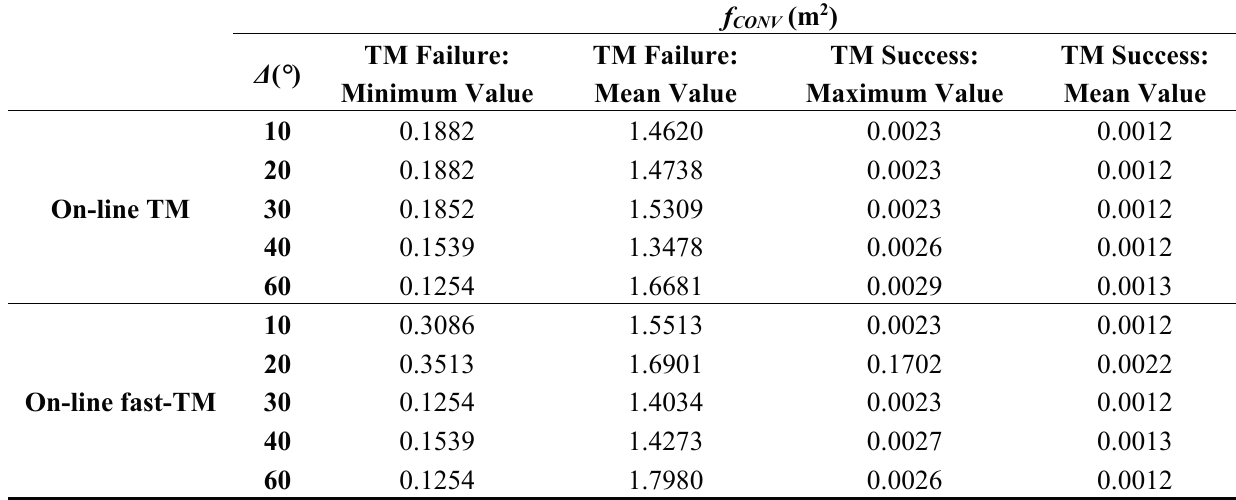
Table 4. Comparison among the values of f CONV in the cases of failure and success of the TM